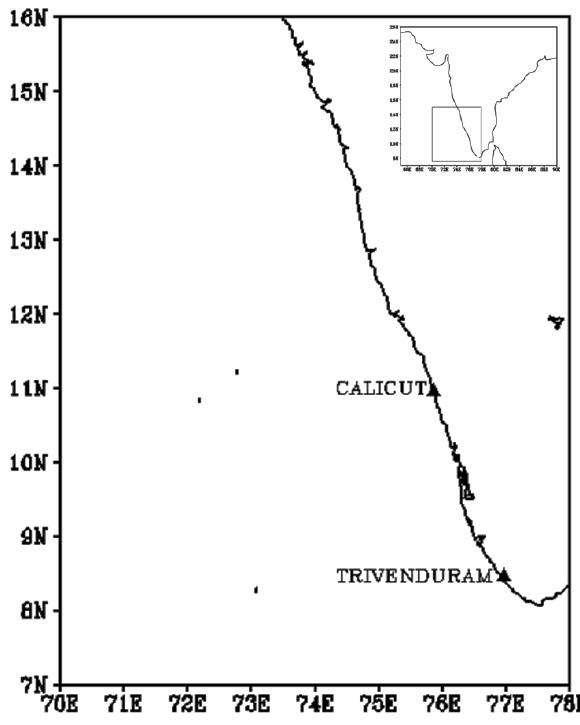
Figure 1. Map of the Southwest coast of India Fig. 1. Map of the Southwest coast of India.